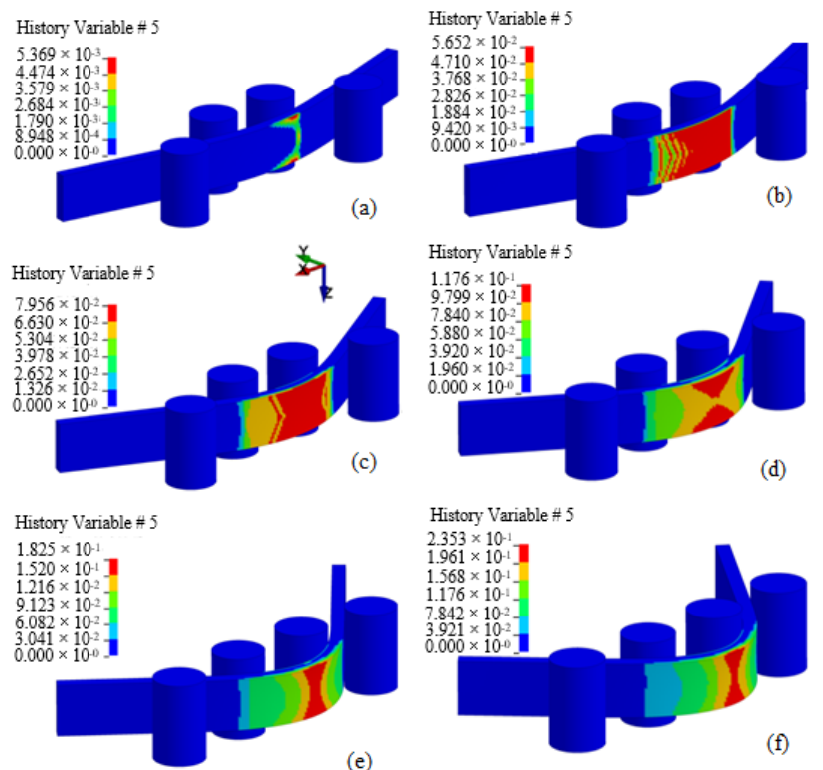
Figure 15. Evolution of damage with the inherent damage law of SAMP-1 material model at different indenter displacements: ( a ) 5 mm, ( b ) 7 mm ( c ) 8.8 mm, ( d ) 11.2 mm, ( e ) 14 mm, and ( f ) 16.4 mm.